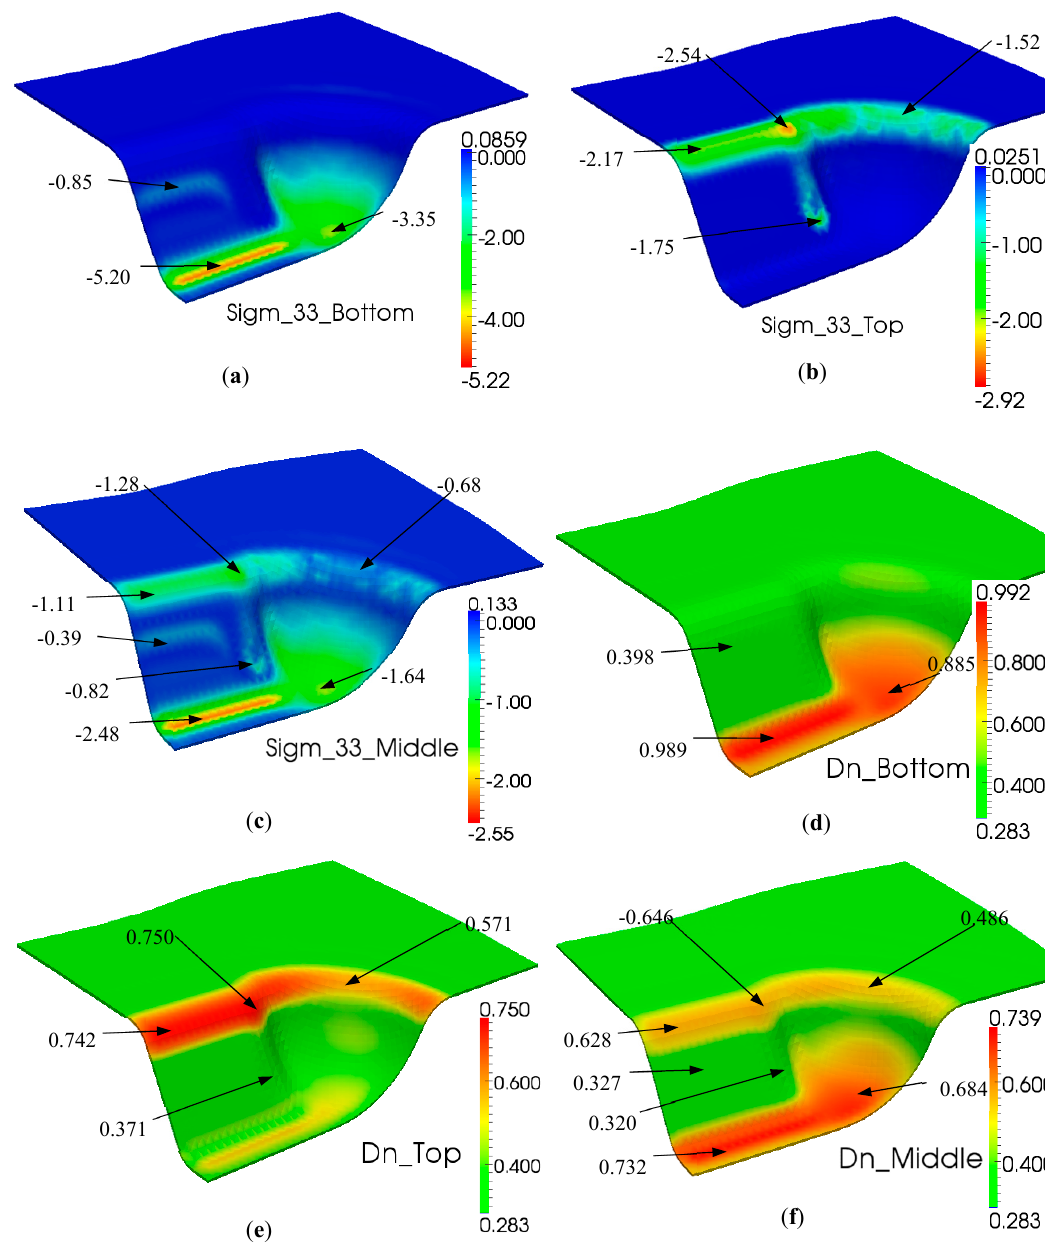
Figure 11. Simulation results during the forming step of a double dome test. Normal stress σ 33 in ( a – c ) and intimate contact Dn in ( d – f ).